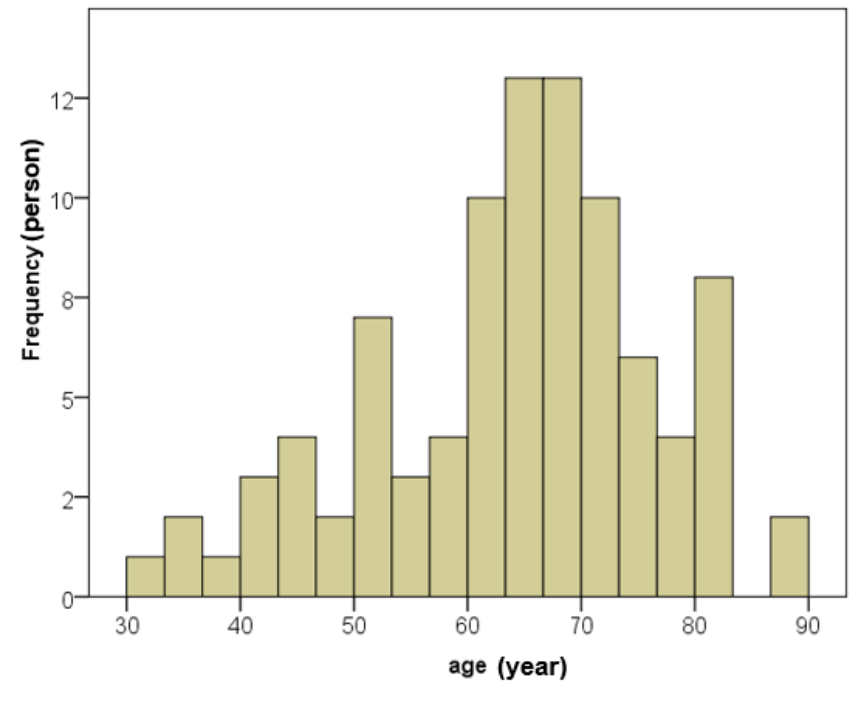
Figure 1 : Frequency distribution of GC patients' ages.